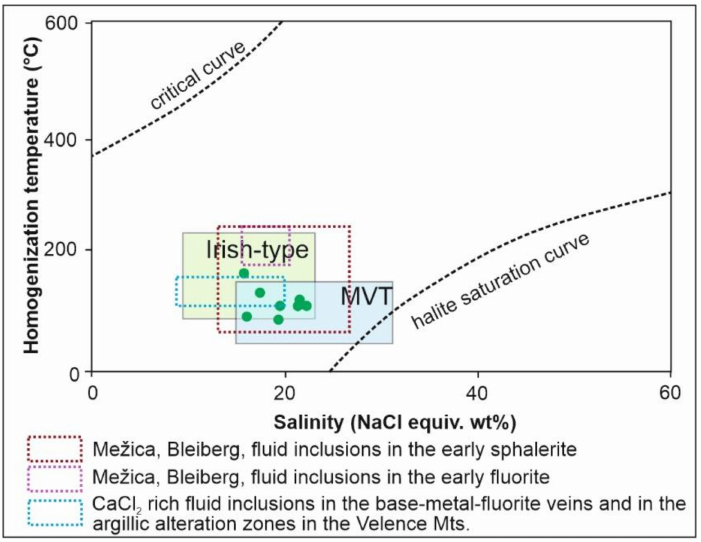
Figure 8. Salinity vs. T h illustrating typical ranges for inclusions from different types of deposits [38]. For comparison purposes, fluid inclusion data for two Alpine-type epigenetic lead-zinc deposits in the Drau Range (Bleiberg, Mežica) [39], the Pb-Zn-fluorite mineralization of the Velence Mts. [6], and the primary fluid inclusions from P é csely (green dots) are also shown. Fluid inclusions from P é csely plot within the MVT field and overlap with data from Mežica, Bleiberg, and Velence